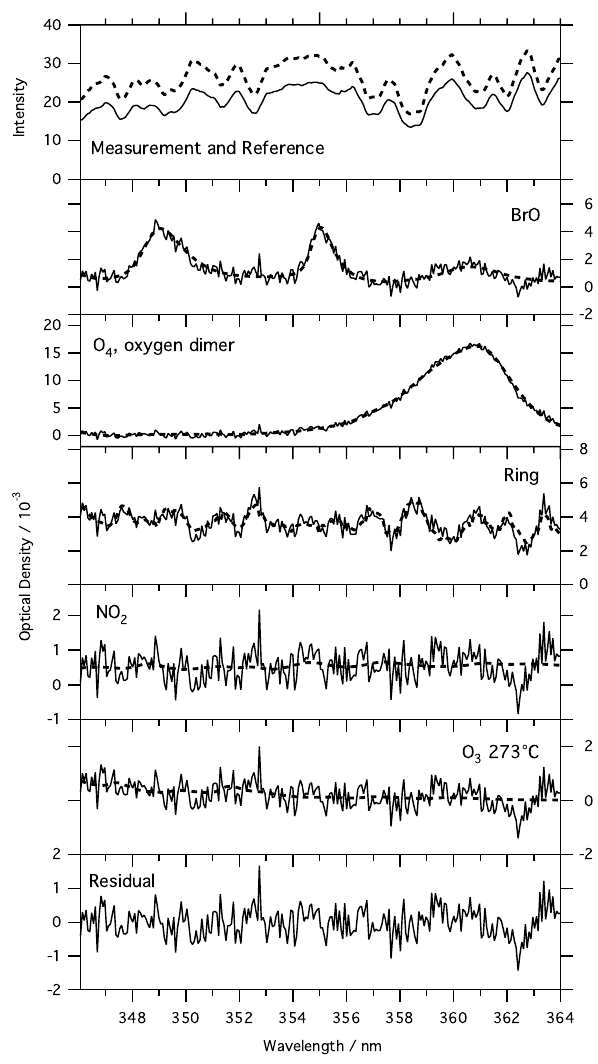
Fig. 6. Example of a spectral fit from Barrow, Alaska on 18 March 2009. The view elevation angle is 2 ◦ above the hori- zon and solar zenith angle (SZA) is 74 ◦ . In each panel, the solid line is the measurement spectrum and dotted line is the modeled partial fit, or the reference spectrum in the case of the top plot. The observed differential slant column densities (which are the fit coefficients) are as follows: BrO: 4.96 × 10 14 molecules/cm 2 , O 4 : 3.83 × 10 43 molecules 2 /cm 5 , NO 2 : 1.17 × 10 15 molecules/cm 2 , O 3 at 273K: 1.62 × 10 18 molecules/cm 2 . The RMS deviation of the residual spectrum from zero is 4.40 × 10 − 4